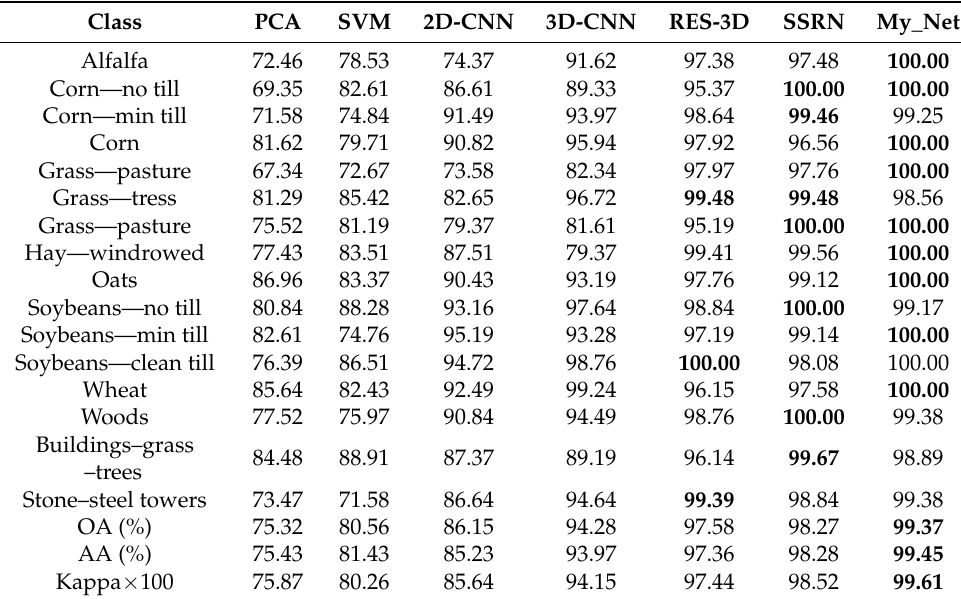
Figure 16. Overall accuracy curve of different models in Indian Pines dataset. Table 6. Classification results of different models in Indian Pines .